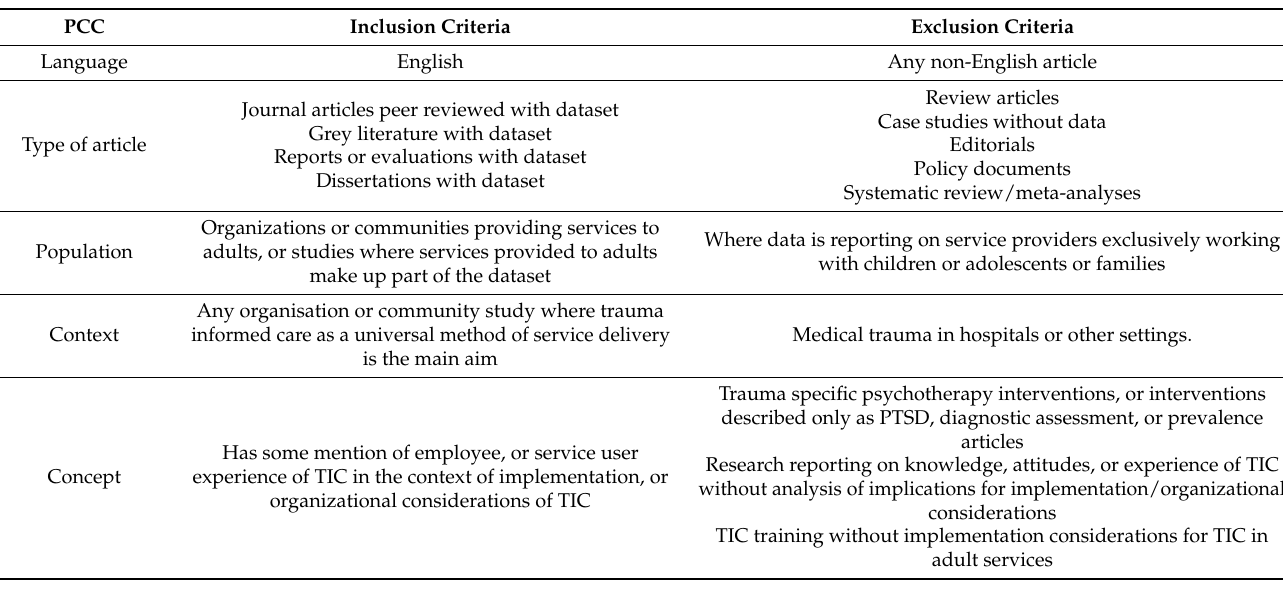
Table 1. Inclusion/exclusion